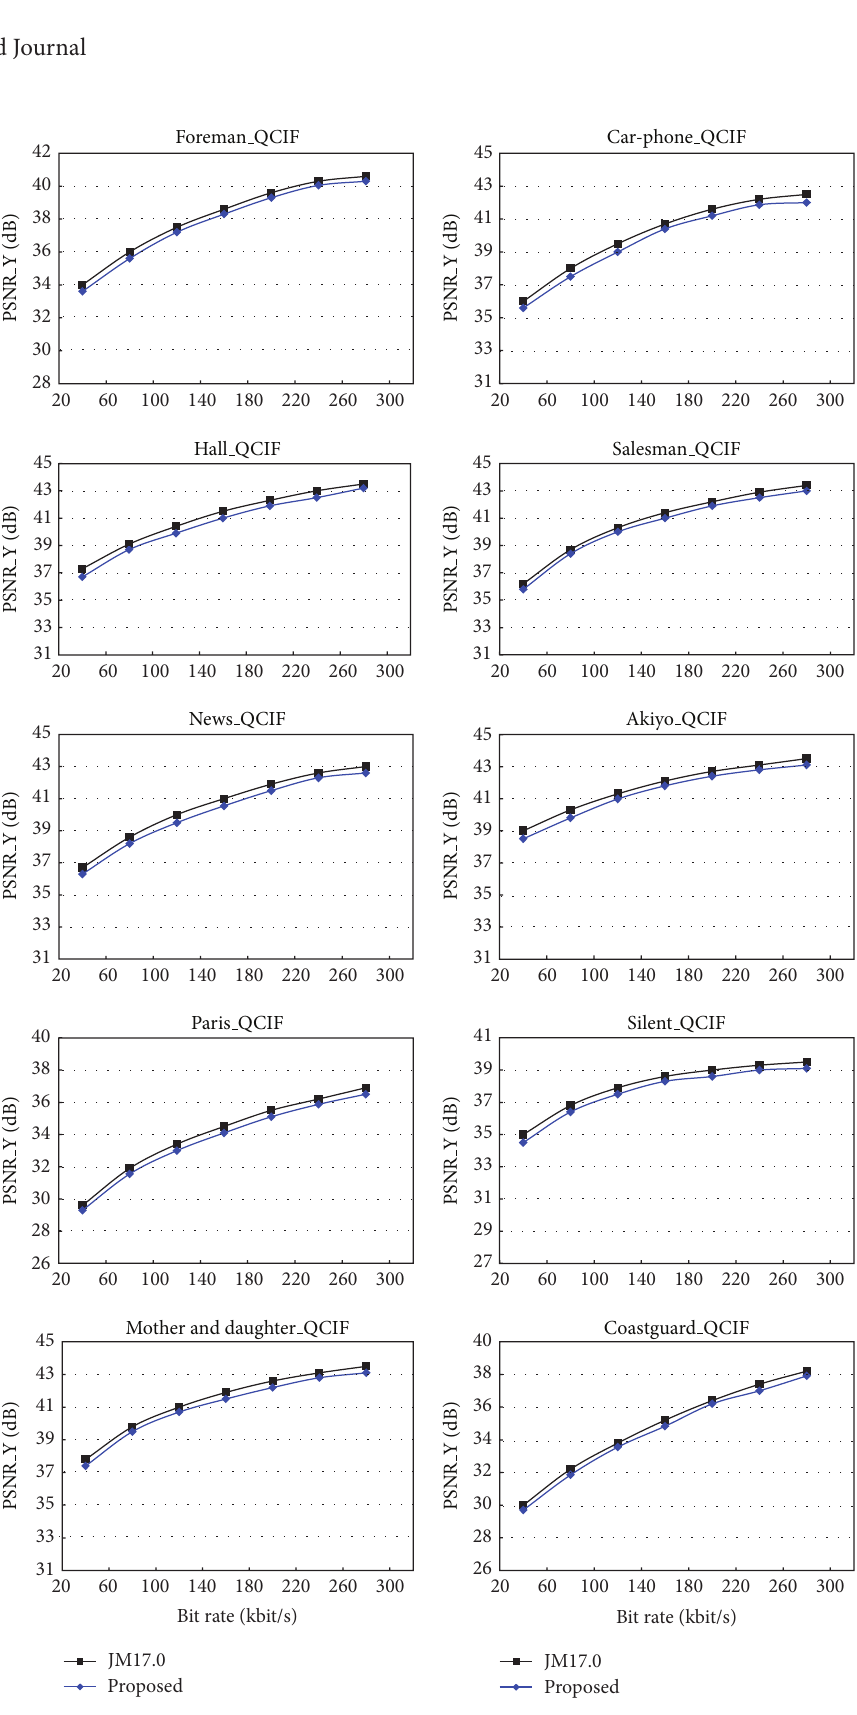
Figure 5: Comparison of the rate-distortion